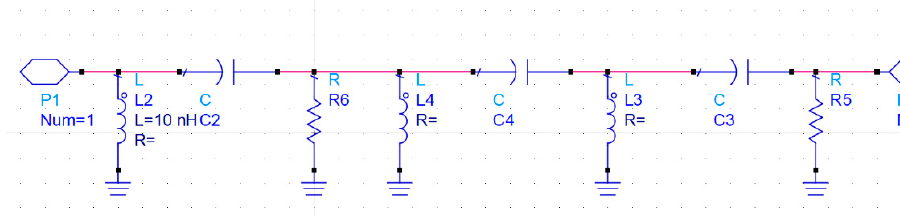
Figure 17 . Fifth-order derivative circuit.